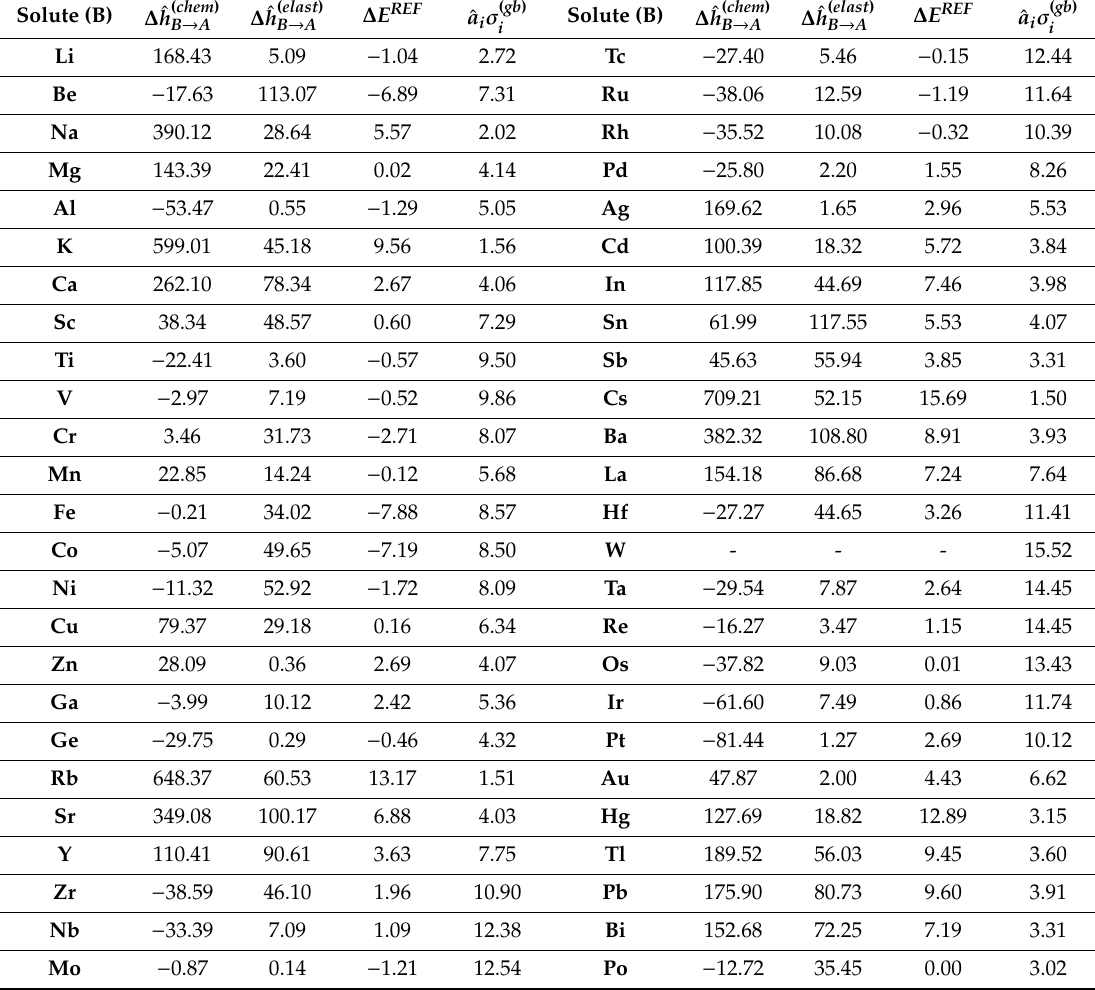
Table 1. Parameters used in this work (All values are in kJ /